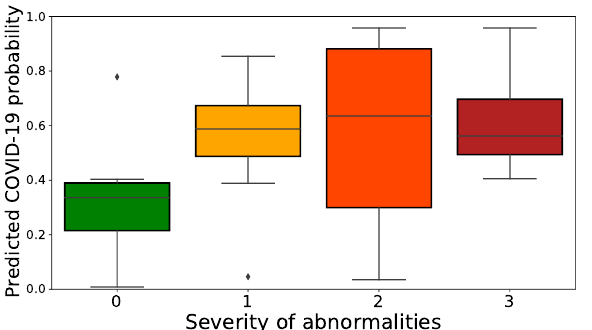
Figure 4. Performance of our model on an independent test set. Predicted probability for COVID-19 of our model compared to the severity labels of ICLUS (colors correspond to COVID-19